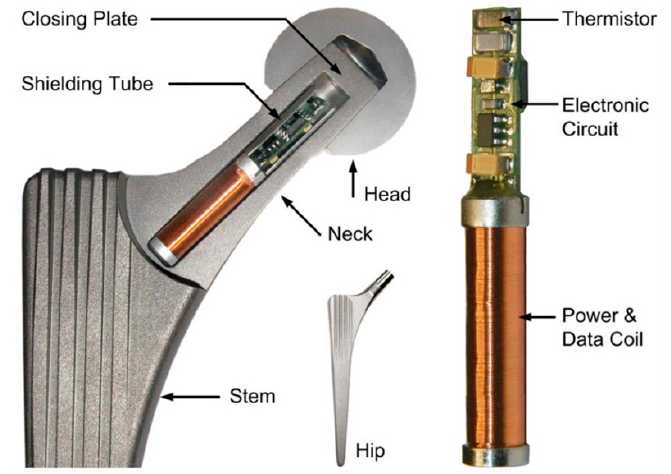
Figure 4. A smart hip implant featuring a telemetered temperature sensor to detect loosening. CC BY [85] .